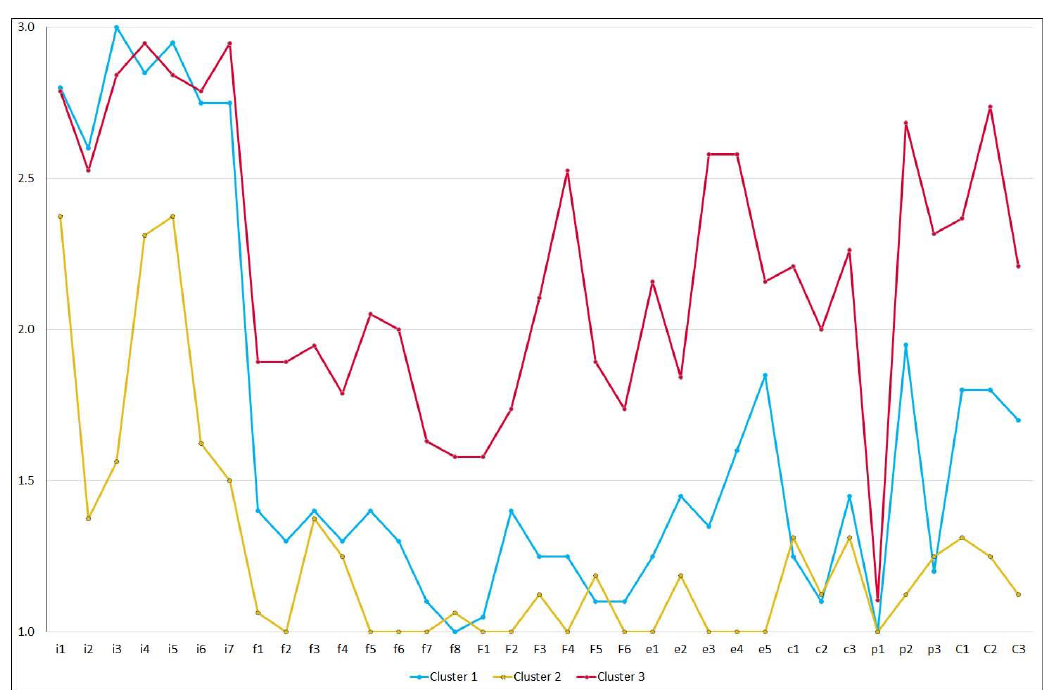
Figure 3. Multidimensional scaling (MDS) of the final three-cluster solution. 4. Discussion This pilot exploratory study applied cluster analysis to the Family Needs Survey (FNS, 1990 version) scores obtained from 68 parents to form support groups with sizes ranging from 5 to 20 members through the identification of parental needs subtypes con- cerning their 5-year-old children with probable neurodevelopmental disorders. Hierar- chical agglomerative clustering with Ward’s linkage method classified 55 of 68 parents